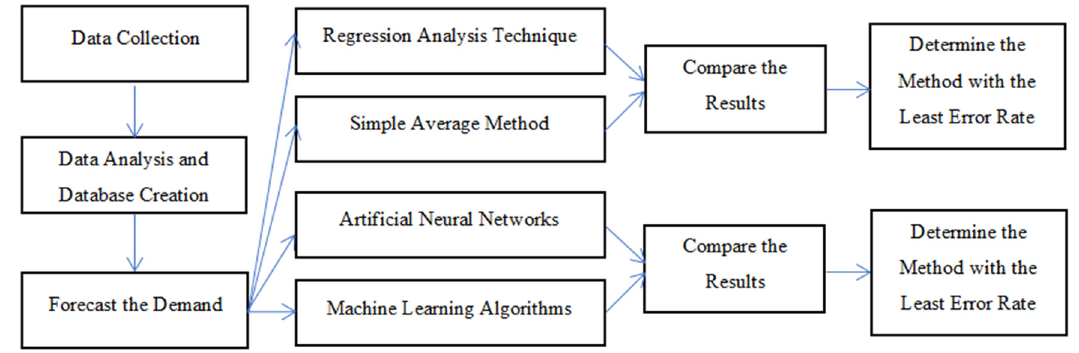
Figure 1: Steps of the